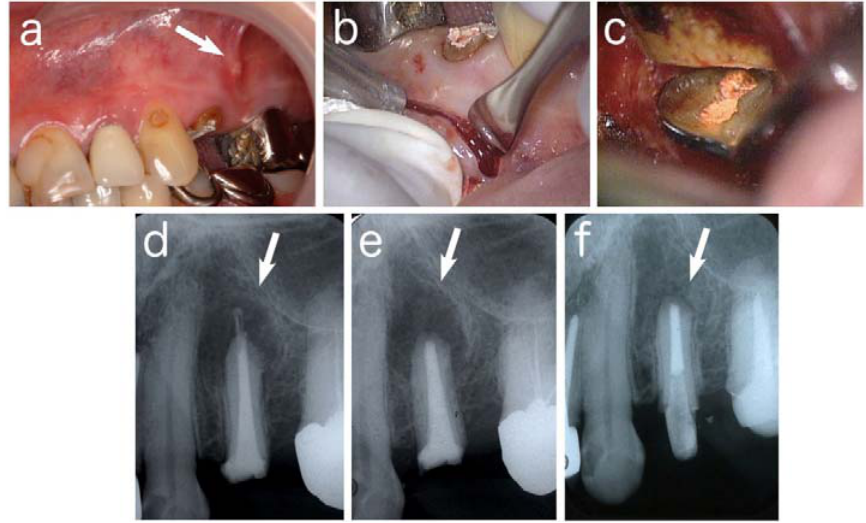
Figure 2. ( a ) Fistula formed at buccal site of left maxillary first premolar; ( b ) Incision for apicectomy; ( c ) After removal of root apex and infected granulation tissue; ( d ) Radiophotograph of (a). Periapical lesion (arrow) was observed; ( e ) After apicectomy. Bone defect (arrow) was observed; ( f ) Three months after surgery. Bone formation (arrow) was observed.